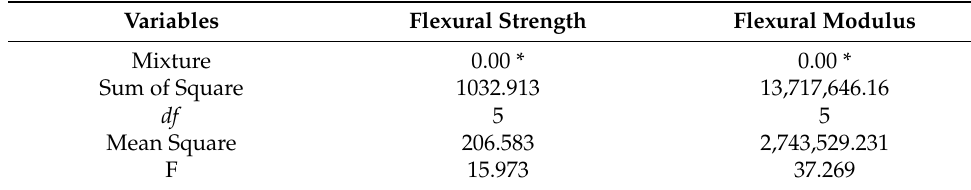
Figure 6. Flexural strength of TPCS + banana leaf fibre. Table 2. ANOVA of flexural